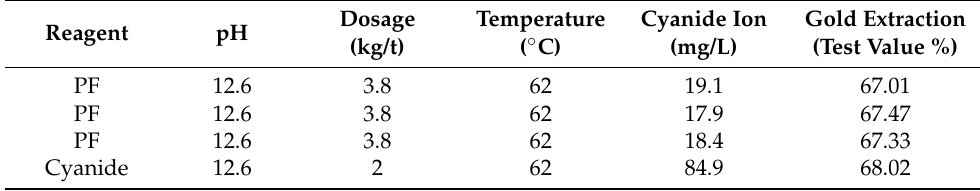
Table 6. Comparison of gold extraction predicted value and test value.